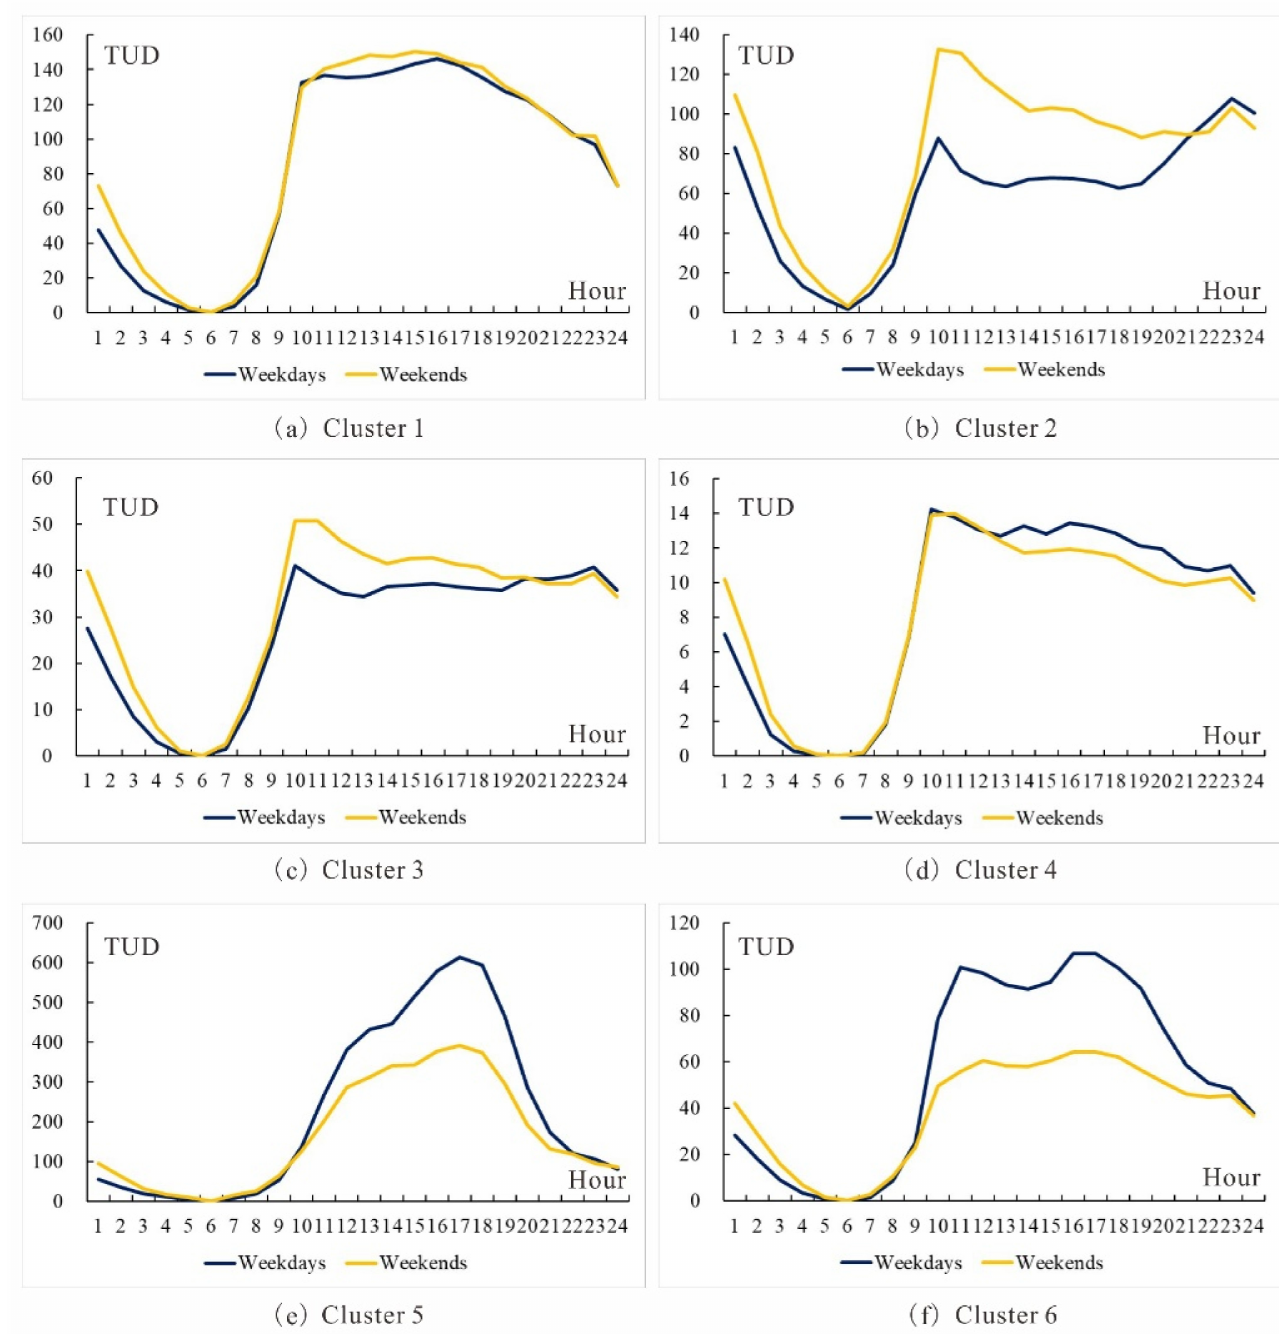
Figure 5. The average hourly TUD for the six clusters on weekdays and weekends. Cluster 2 (urban village/residential district): Regarding the TUD curve (Figure 5b), the TUD value increased significantly between 6:00 and 9:00 as well as 19:00 to 23:00, and it was low on weekdays between 10:00 and 19:00. On weekends, the TUD values were much higher than weekdays. This is a typical temporal pattern of a residential building, which refers to the population’s outflow during working hours on weekdays and staying home during the daytime on weekends. In terms of the POI density index (Table 2), SHS (scenic and historic spots), CS (catering services), HA (hotels and apartments), and LS (living services) had high values. Note that most SHS in this category were ancestral halls in urban villages. This cluster consisted of many urban villages in Tianhe District (e.g., Tangxia, Shipai, and Chebei) and other nearby residential districts. This cluster had